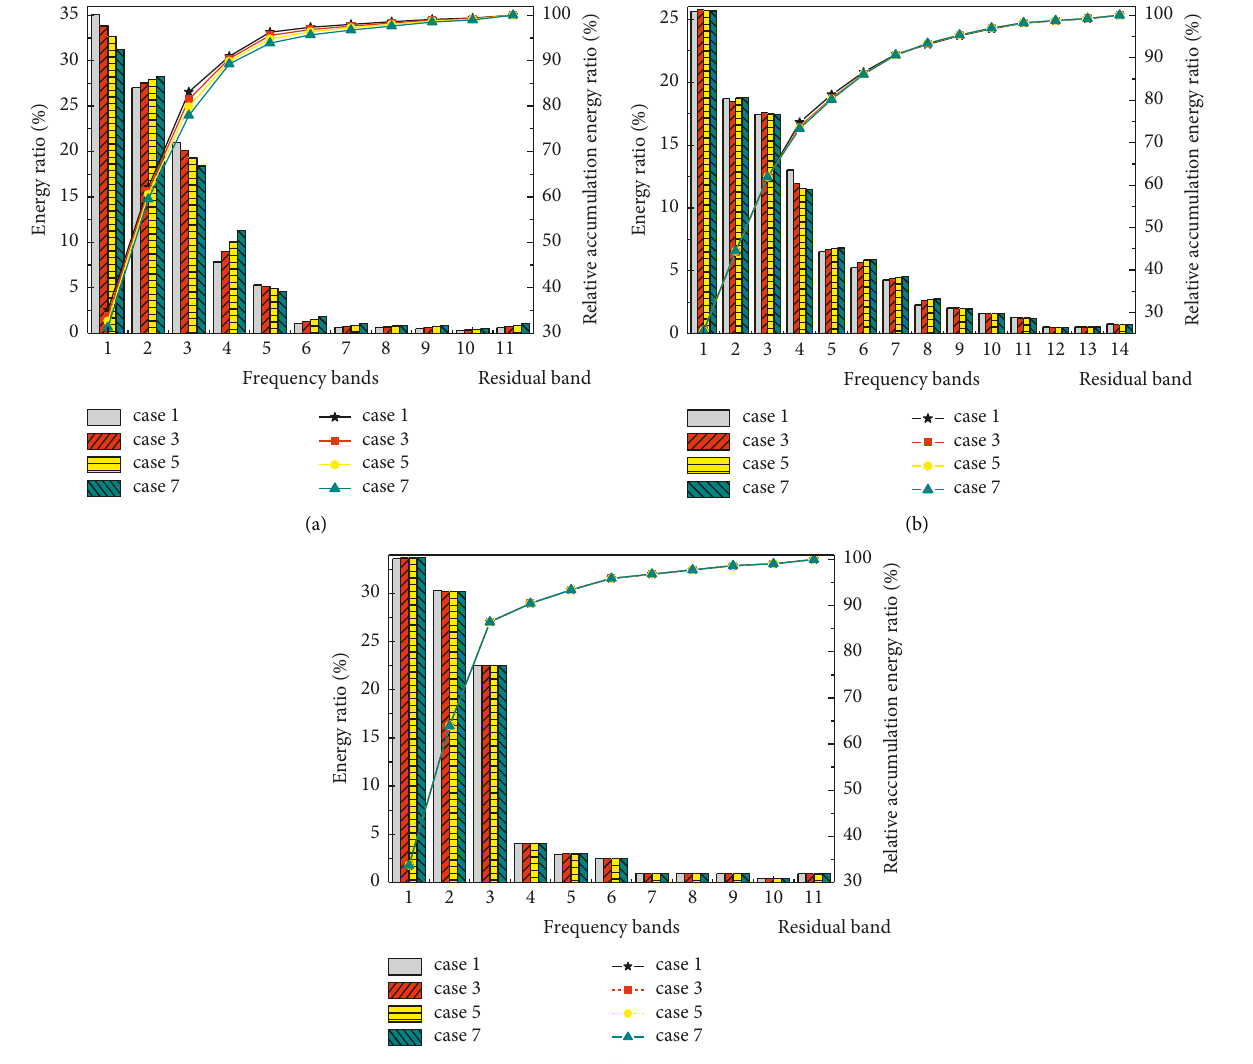
Figure 7: The updated Wavelet Packet frequency bands energy ratio spectrum of different measurement points (the second time test at excitation point II, η 0 � 99%). (a) Point 4. (b) Point 5. (c) Point